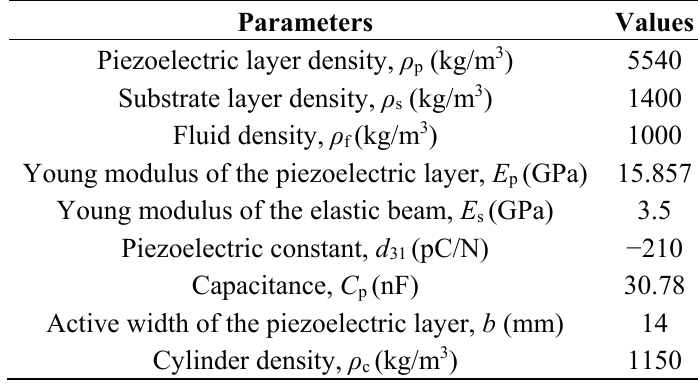
Table 1. Material properties of the piezoelectric energy